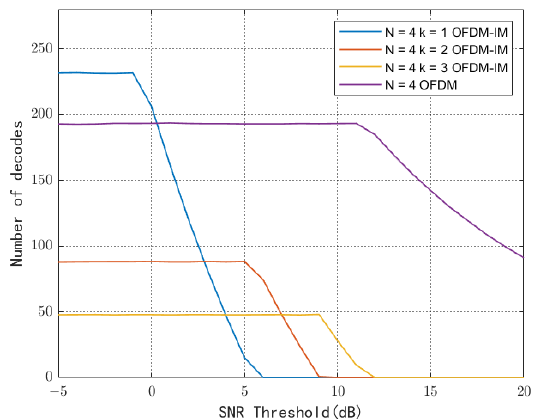
Figure 6. Decoding number comparison under di ff erent SNR.